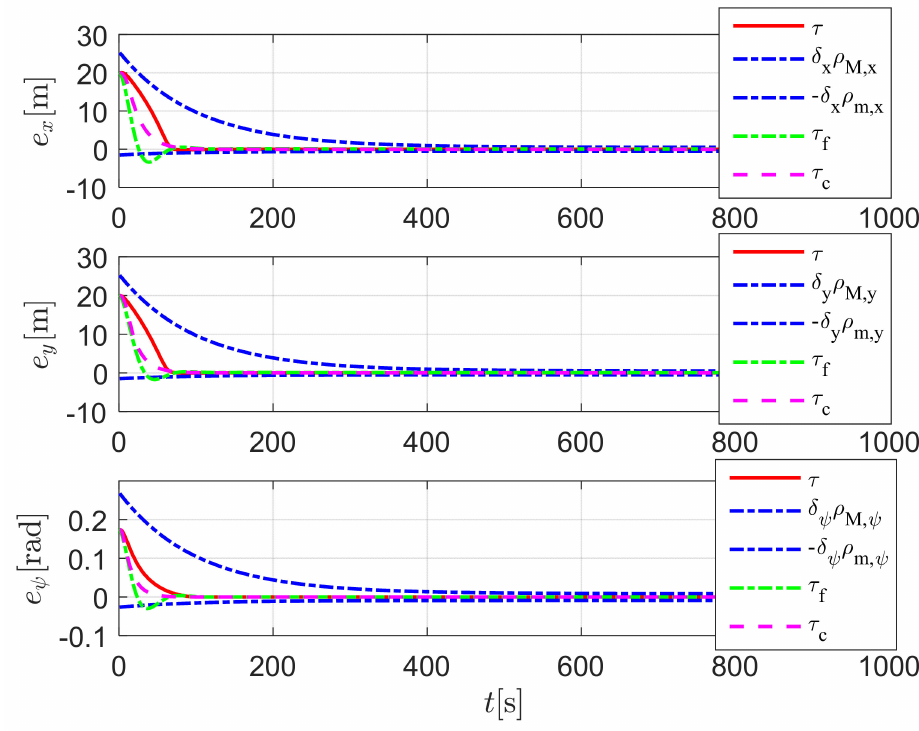
Figure 9. The time response curves of positioning error in Case 2.